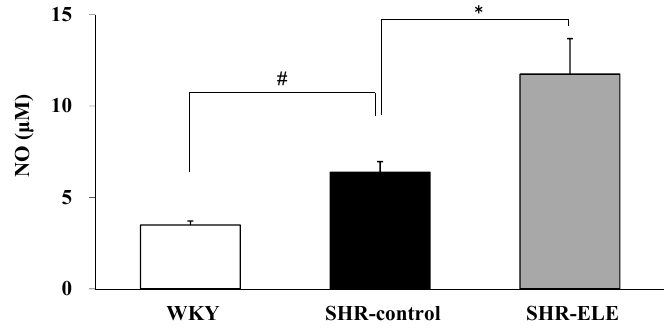
Figure 3. Plasma nitric oxide (NO) levels in the indicated treatment groups. The values represent the means ± SE; * p < 0.05, compared with the spontaneously hypertensive rat (SHR)-control group; # p < 0.05, compared with the Wistar Kyoto rat (WKY) group. ELE, Eucommia leaf extract.